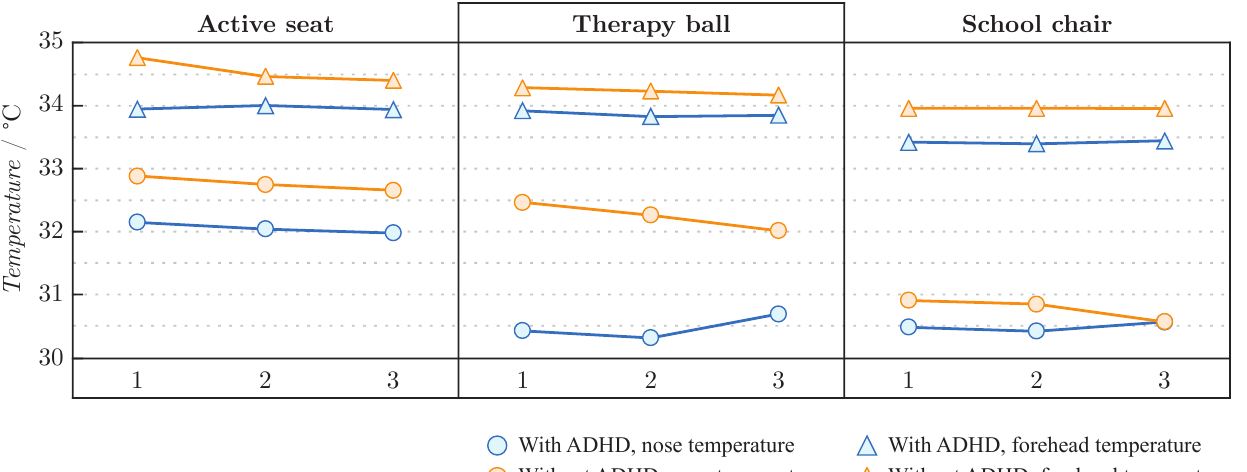
Figure 6. Average forehead and nose temperature of children with and without ADHD while solving cognitive test in active seat, therapy ball and school chair. Moments of interest are marked as 1—explanation of the task, 2—start of task solving, 3—end of task